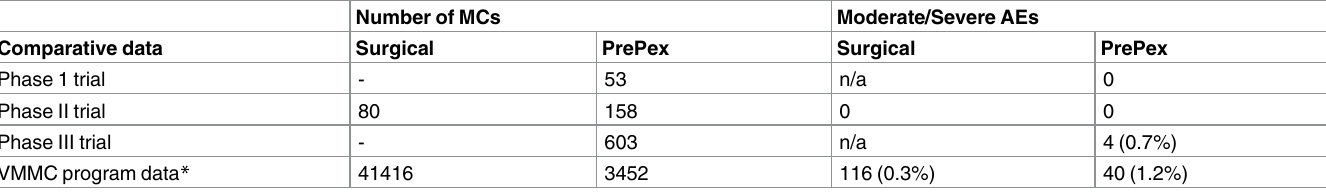
Table 4. Summaryof AEs reported in previous PrePex studies in